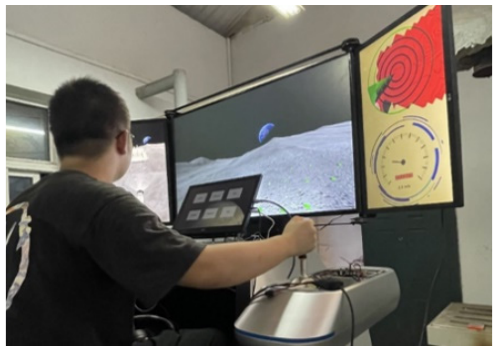
Figure 21. Experiment procedure.